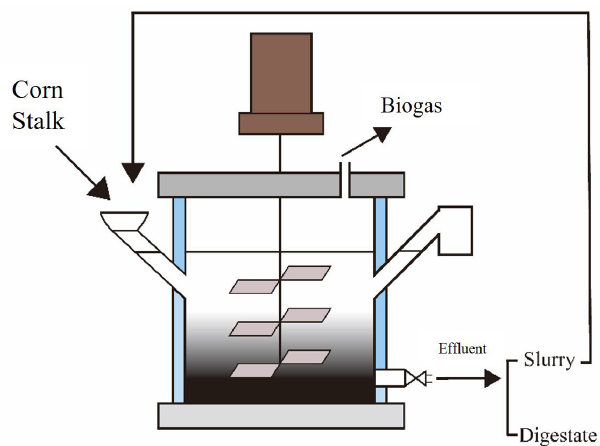
Figure 1. Schematic diagram of the